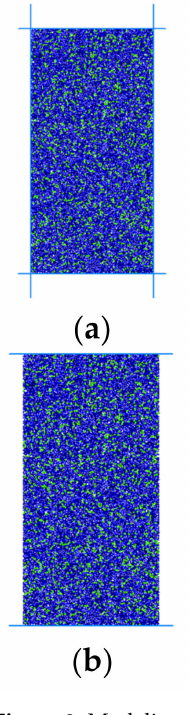
Figure 8. Modeling pressure resistance process: ( a ) generation model of surrounding wall constraints; ( b ) upper and lower wall constraint loading. Table 4. Meso-structure parameters of